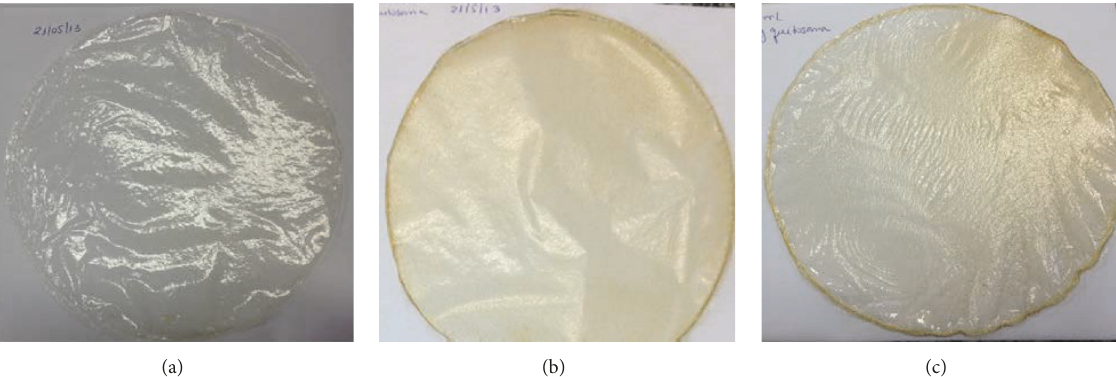
Figure 1: Chitosan membranes associated with the extract of unripe banana peel: (a) Chitosan membrane, CB0; (b) chitosan membrane prepared with the first extract, CB1; and (c) chitosan membrane prepared with the third extract, CB3.